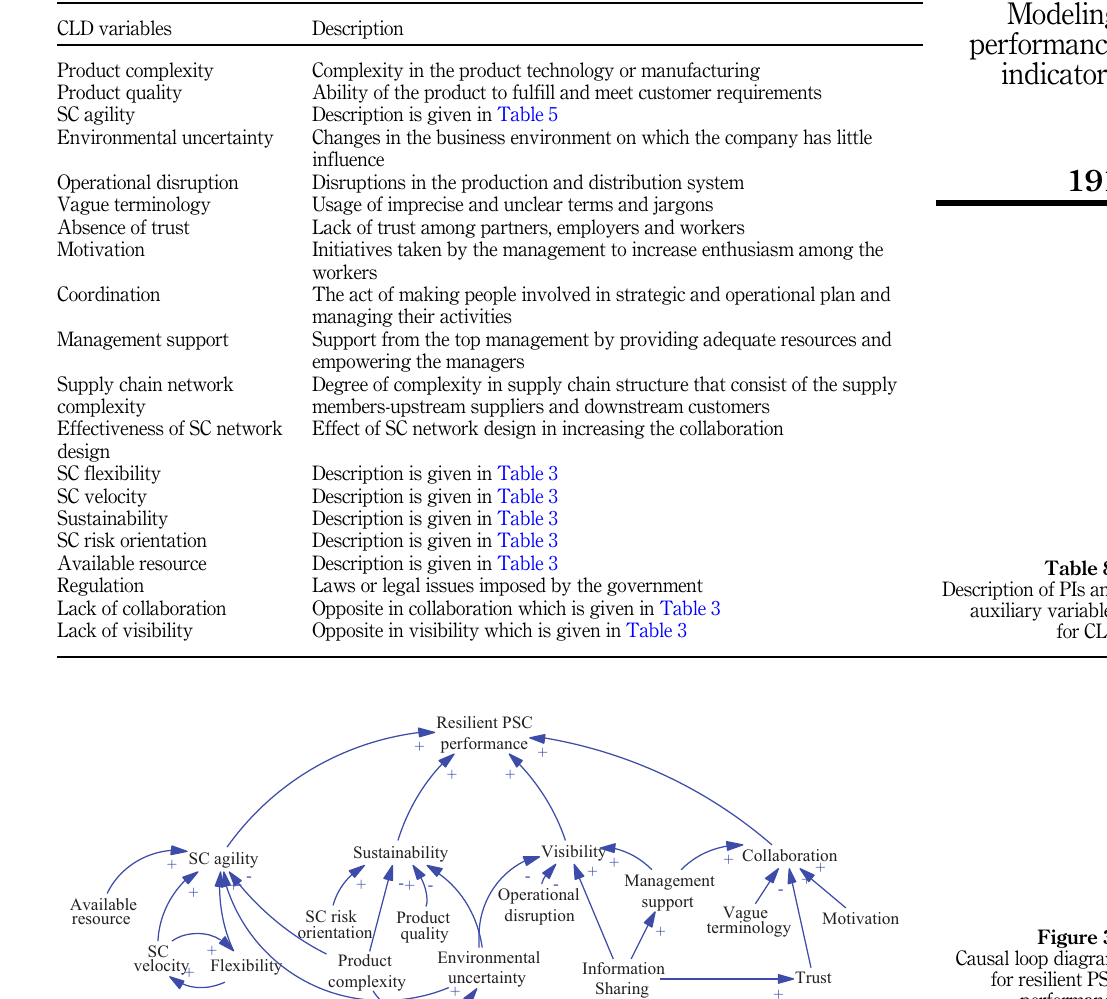
Figure 3. Causal loop